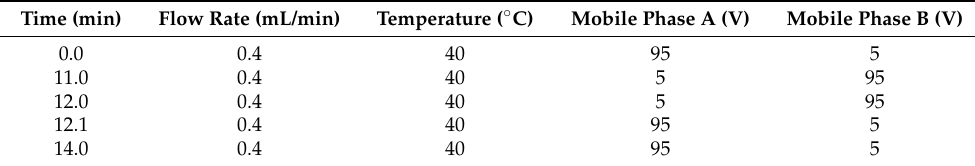
Table 1. Elution